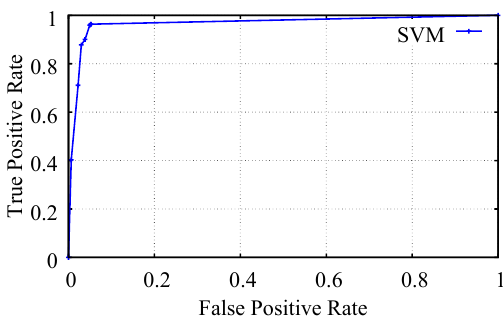
Figure 8. ROC curve for the SVM classifier under the different degrees of minority over-sampling. ROC: receiver operating